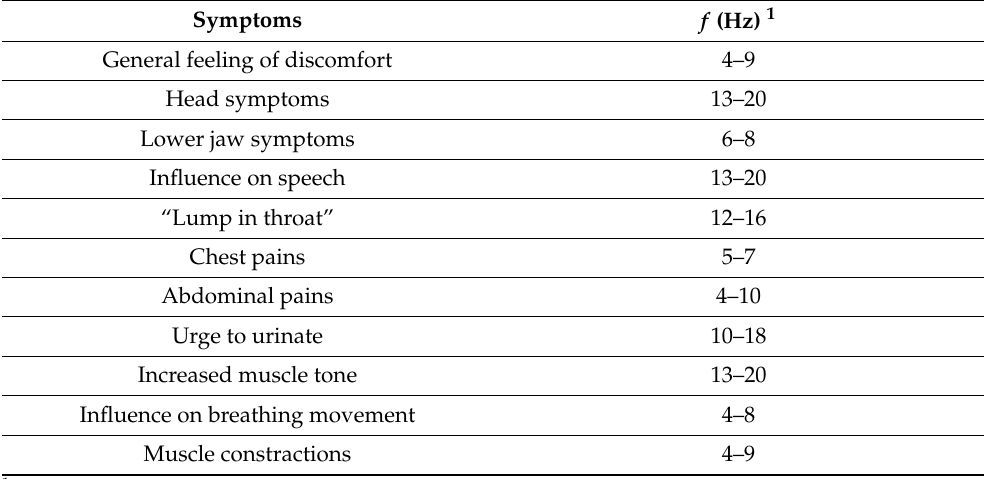
Table 1. Symptoms caused by vibration